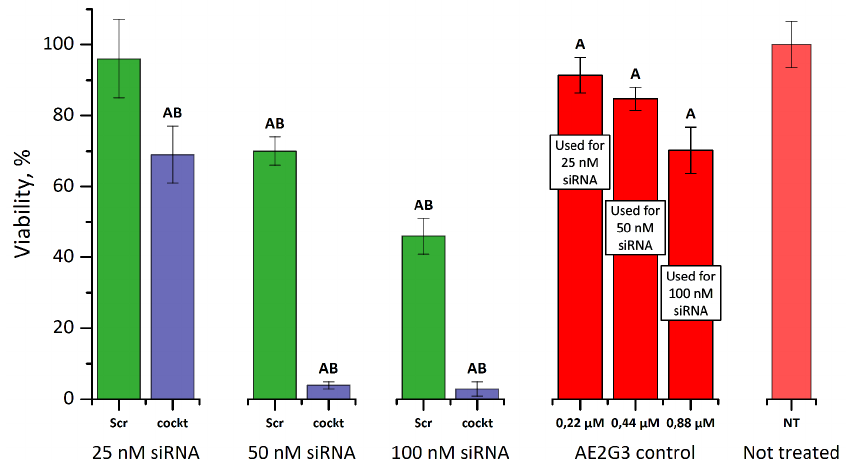
Figure 4. Viability of HeLa cells exposed to AE2G3/pro-apoptotic siRNAs dendriplexes formed at dendrimer/siRNA charge ratio 10:1 for 72 h. A—significant difference to untreated cells (Dunnett test), p < 0.001. B—significant difference to relevant concentration of dendrimer, used to form dendriplex (Dunnett test), p < 0.001. Data are presented as Mean ± Standard Deviation. n for each group was ranged from 18 to 36, n of untreated control = 315.